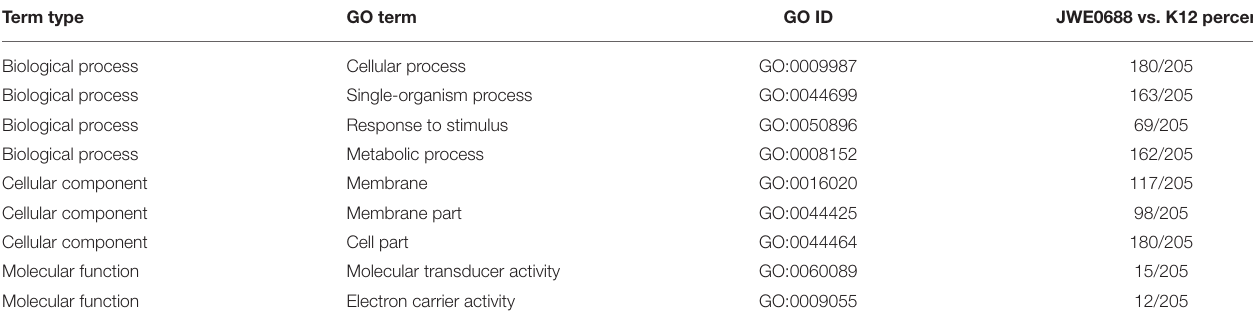
TABLE 5 | GO categories for the up-regulated proteins in E. coli JW0688.